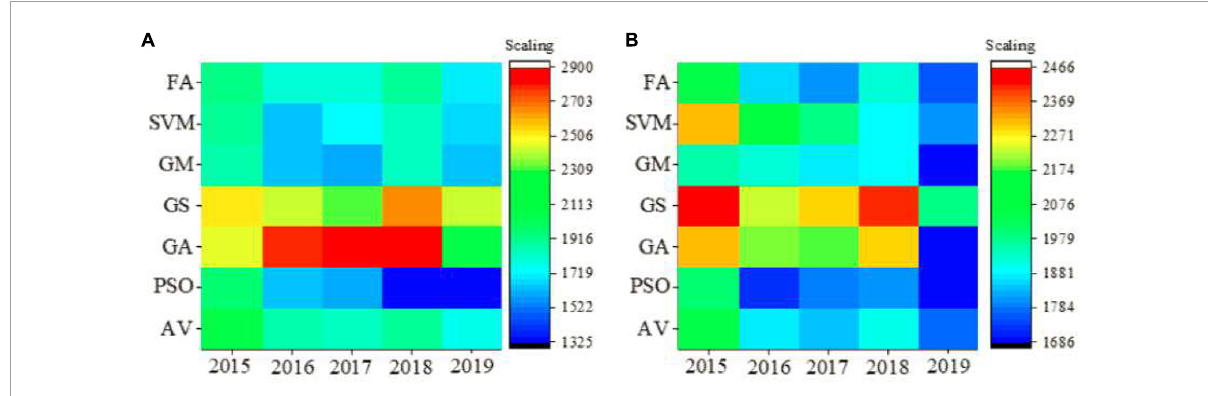
FIGURE7 (A) Prediction result of tax model of the first industry in ceramic industry. (B) Prediction result of tax model of the second industry in ceramic industry.